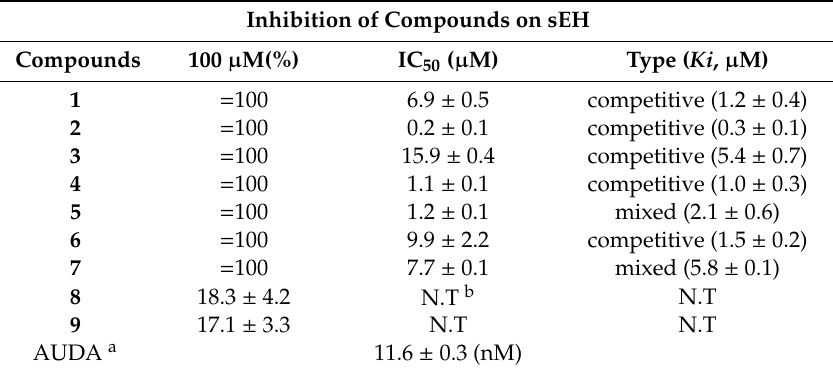
Table 1. Inhibitory e ff ects of isolated compounds 1 – 9 .